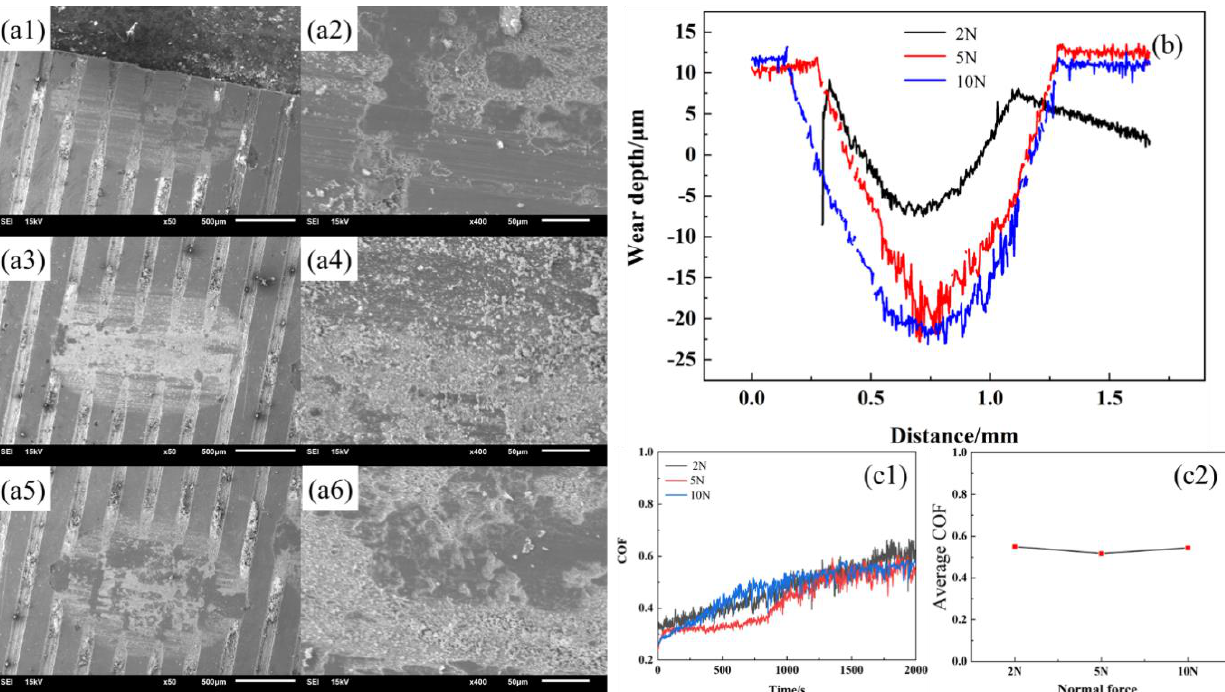
Figure 14. Morphology of Mn-Cu samples ( a1 ) T0.3-W0.1-C0.3-2N, ( a2 ) Enlarged view of a1 ( a3 ) T0.3-W0.1-C0.3-5N, ( a4 ) Enlarged view of a3, ( a5 ) T0.3-W0.1-C0.3-10N, ( a6 ) Enlarged view of ( a5 ); ( b ) Wear depth of samples; ( c1 , c2 ) Coefficient of friction of samples.